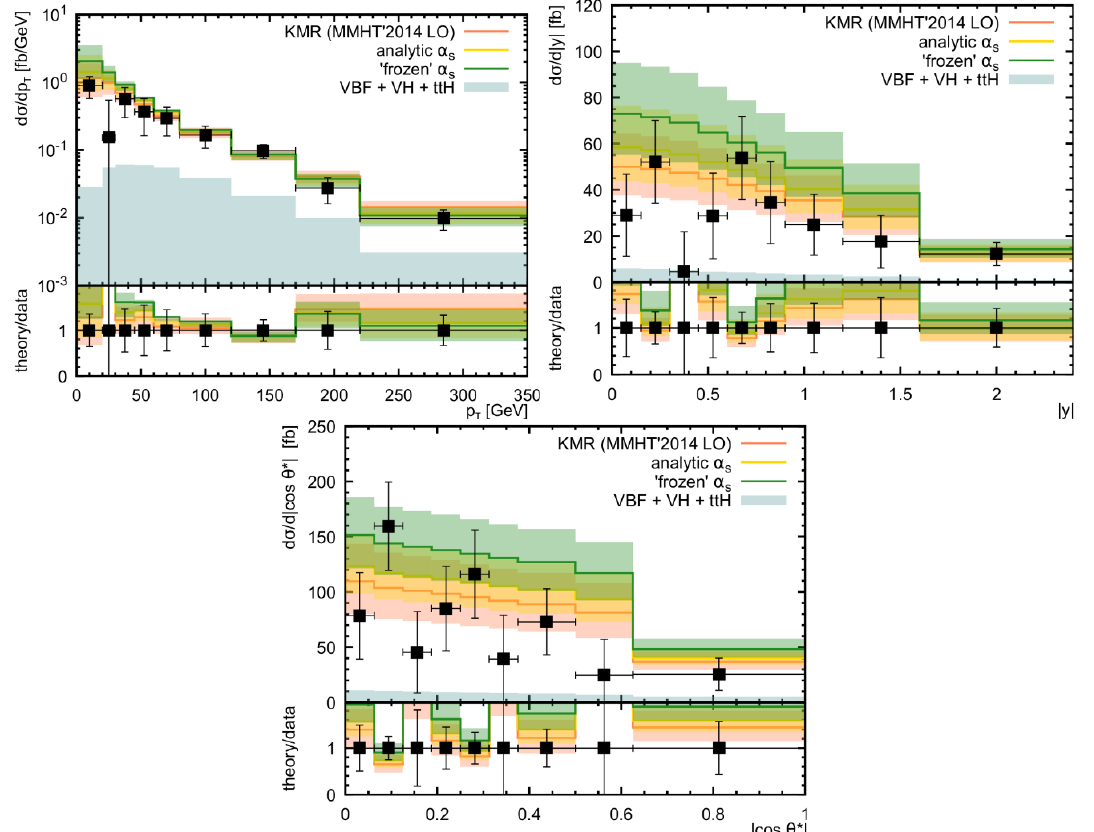
Figure 7 . The di(cid:11)erential cross sections of inclusive Higgs boson production (in the diphoton p decay mode) at s = 13 TeV as functions of diphoton pair transverse momentum p (cid:13)(cid:13) y (cid:13)(cid:13) and photon helicity angle cos (cid:18) (cid:3) (in the Collins-Soper frame). The experimental data are from ATLAS